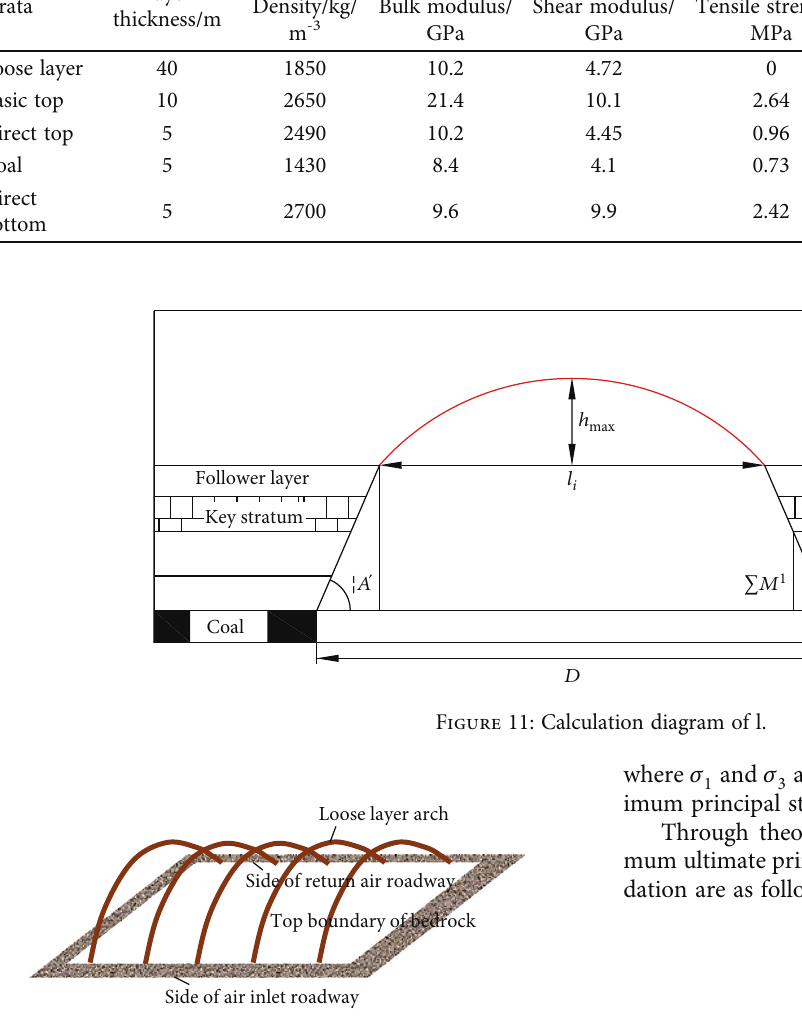
Figure 12: Schematic diagram of arch structure development.